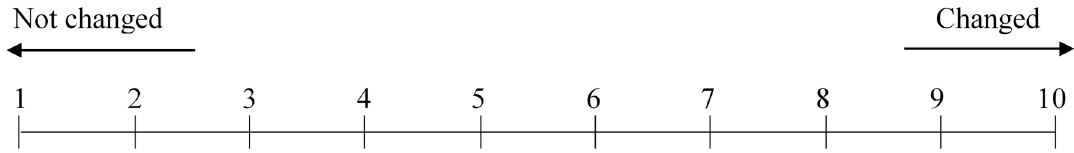
Figure 2. Example from the questionnaire: ‘How much do you think that your water usage has changed?’